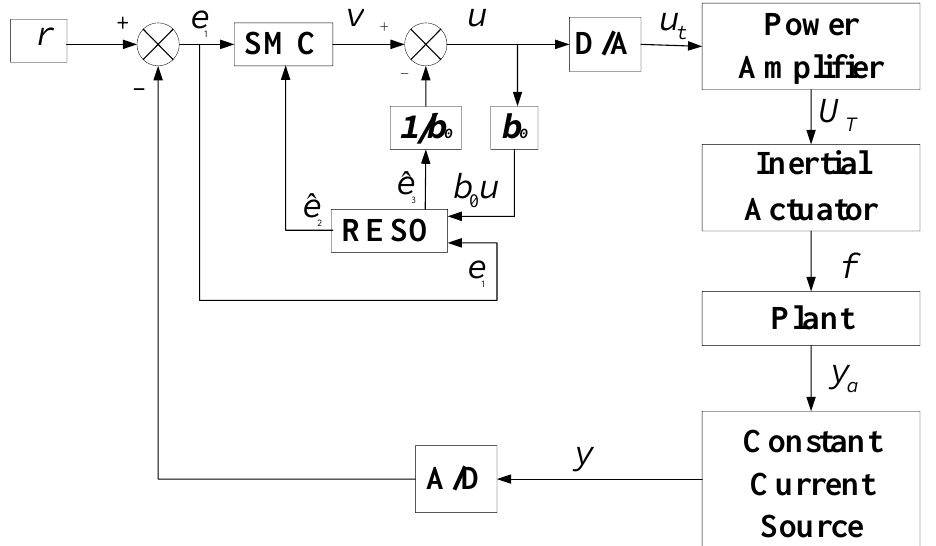
Figure 3. Vibration control system